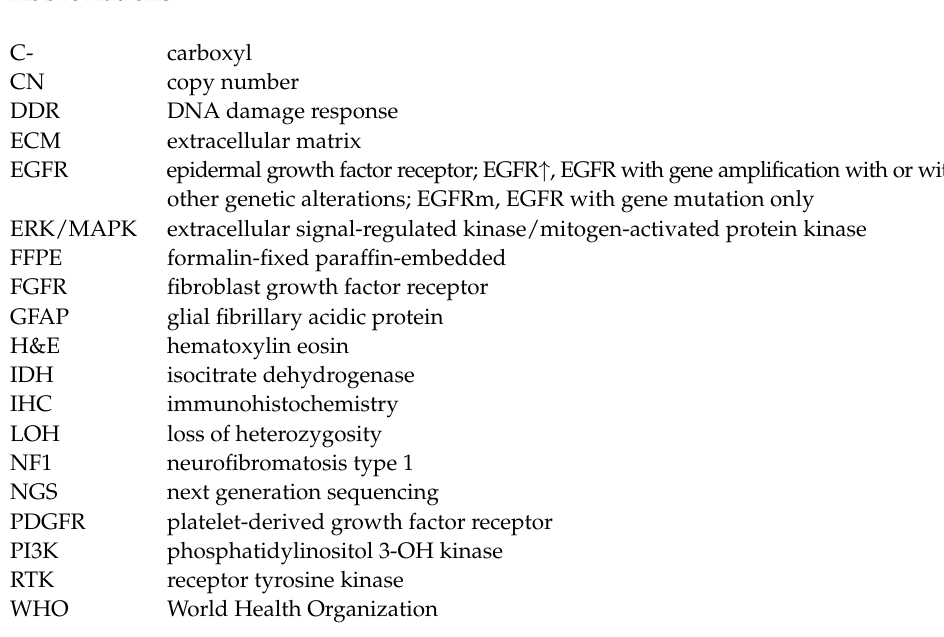
Figure S2: Glioblastoma subgroups—tumor mutation burden, Figure S3: Glioblastoma subgroups— proliferation, Figure S4: Glioblastoma subgroups—correlation matrix, Figure S5: Glioblastoma